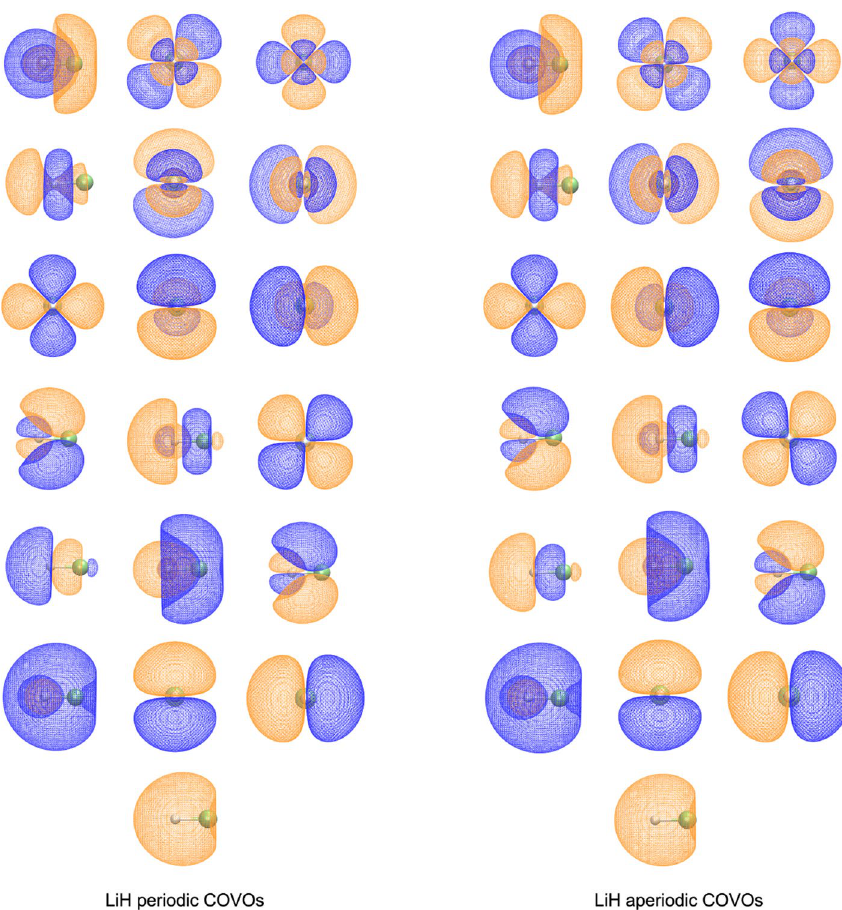
Fig. 7 The 1 filled RHF orbital and 18 COVOs for the LiH molecule from periodic and aperiodic plane-wave FCI calculations are shown on the left and right panels respectively. The orbitals are displayed in the order of increasing orbital energy from left to right and bottom to top. The distance between two atoms at which the energy achieves its minimum is 1.6 Å for LiH. The positive and negative isosurfaces are colored in blue and orange